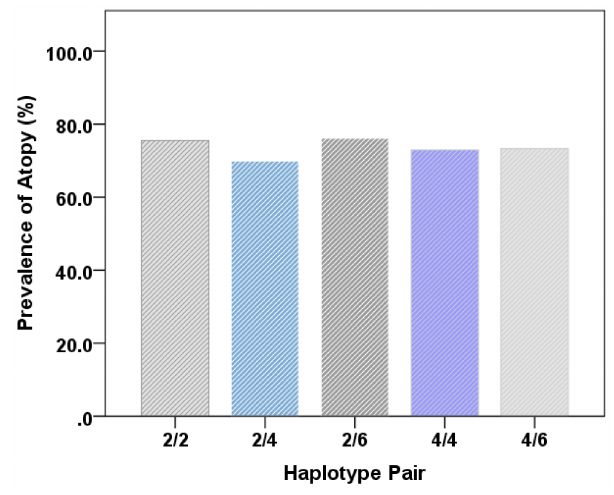
Figure 3. Prevalence of Atopy Similar Amongst Common ADR b 2 Haplotype Pairs (n=2979).